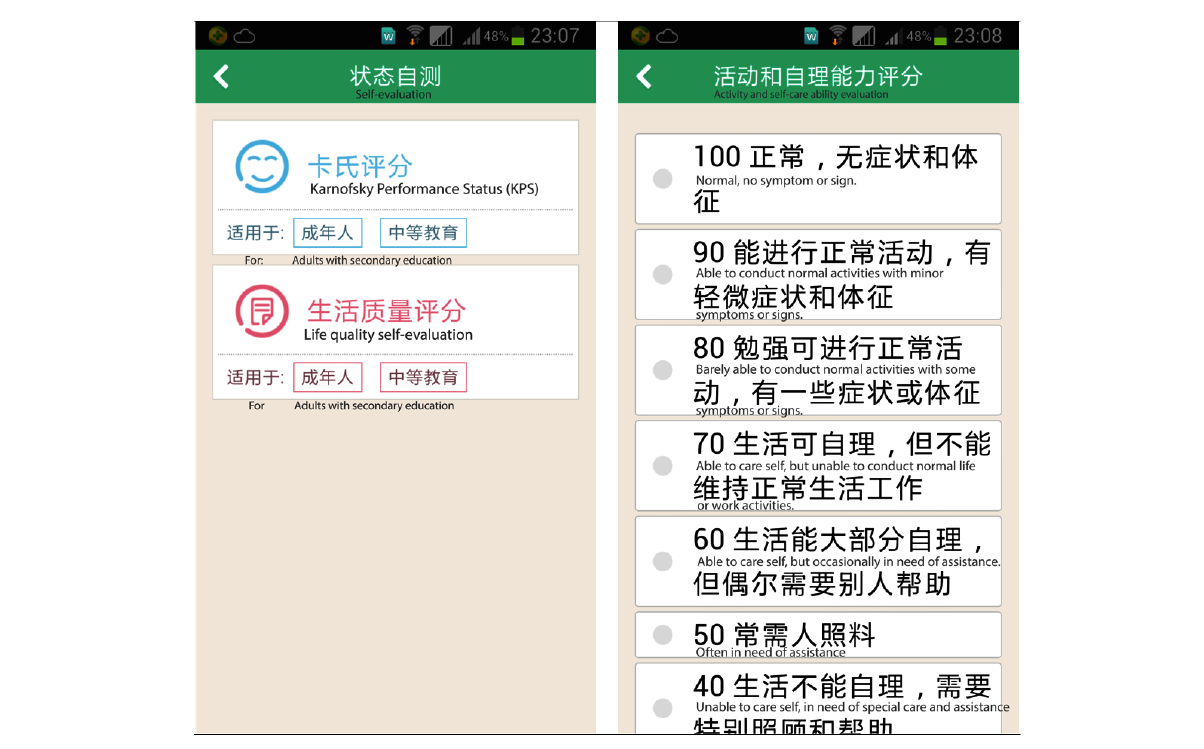
Figure 2. Screenshot of Karnofsky Performance Status (KPS) life quality self-evaluation